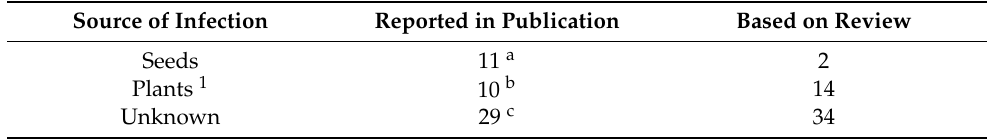
Table 8. Conclusions on the most probable source of pospiviroid infections in tomato crops as reported and drawn upon in the current review of the provided